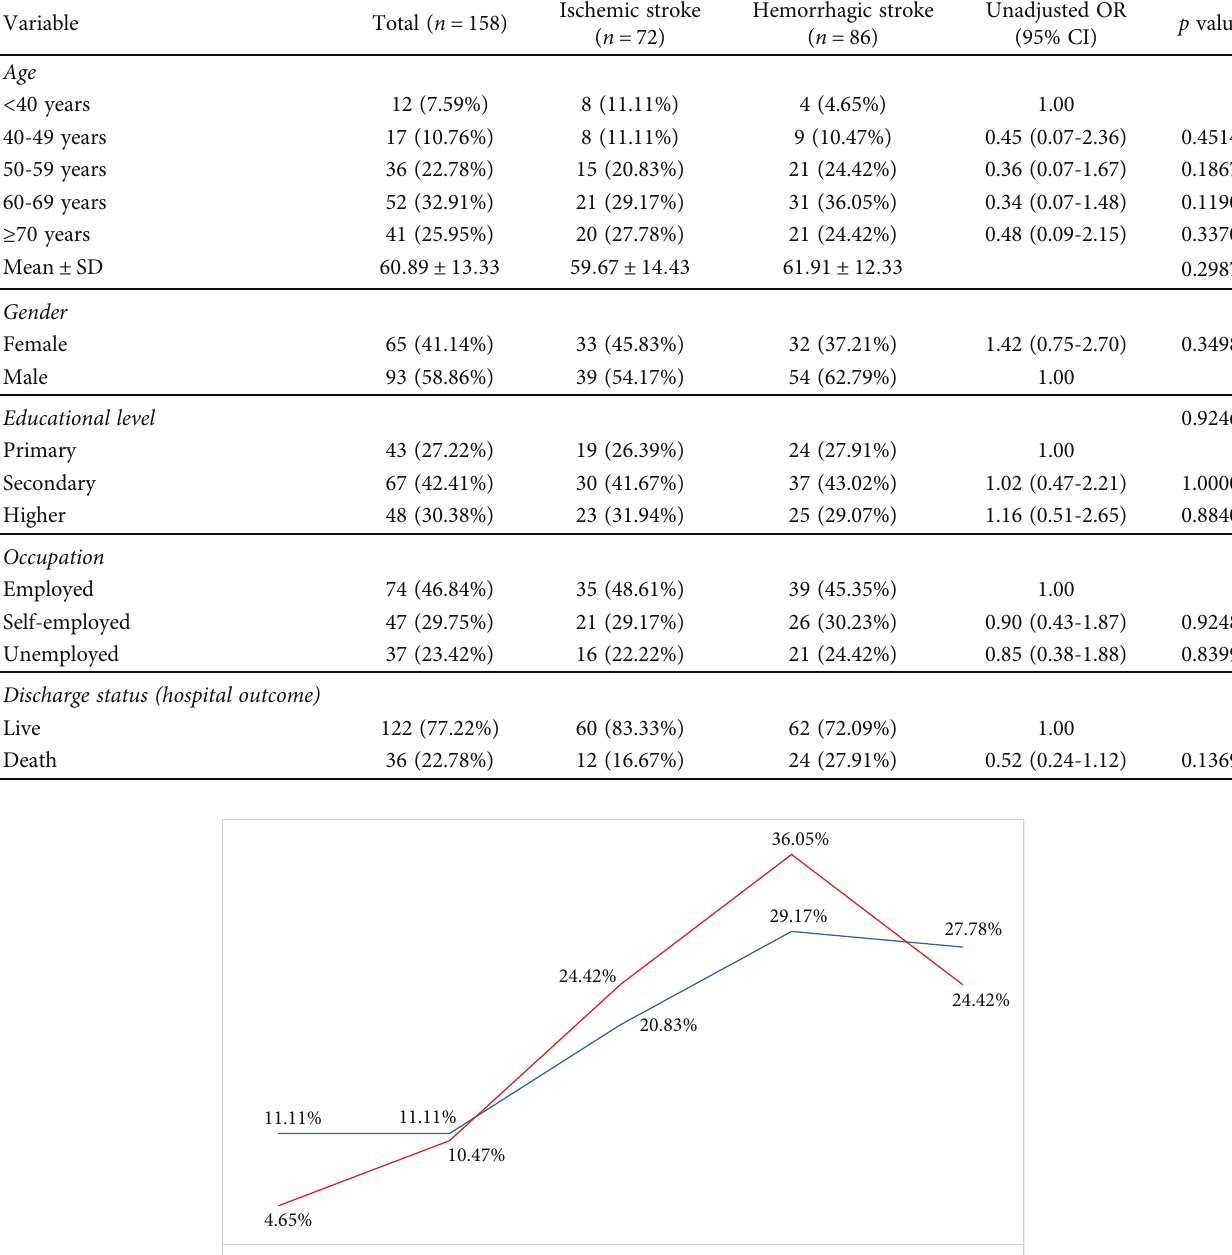
Table 1: Distribution of age, gender, educational level, occupation, and discharge status as well as their association with acute stroke subtypes.